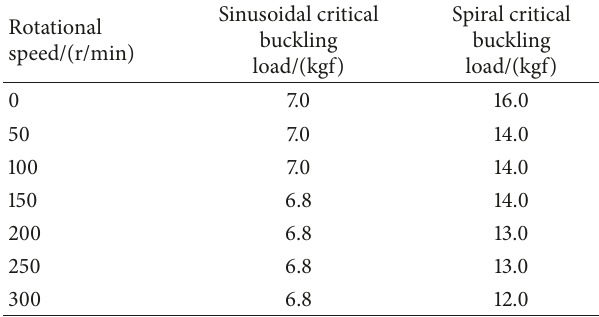
Table 5: Experimental results of critical buckling load of the drill string.